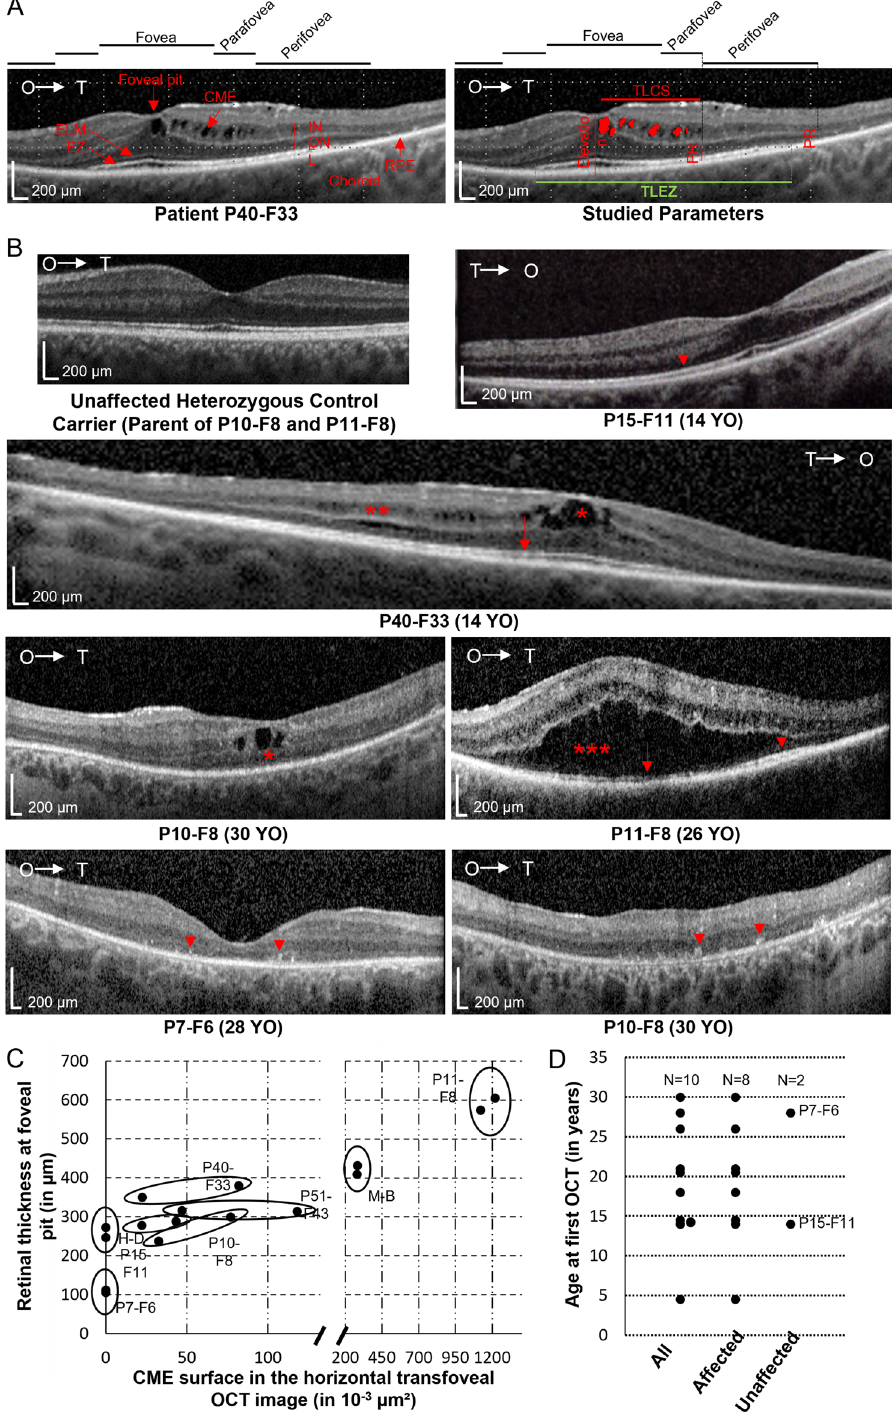
Figure 1. Macular lesions defined by OCT examinations in CS patients. ( A ) Parameters analyzed in this study are presented on an example of an OCT image from a CS patient (P40-F33). CM Cystoid Macular Edema, ELM External Limiting Membrane, EZ Ellipsoid Zone, INL Inner Nuclear Layer, ONL Outer Nuclear Layer, PR Photoreceptor-related layers, TLCS Transversal Length of Cystoid Space, TLEZ Transversal Length of Ellipsoid Zone. ( B ) Transfoveal OCT scans from CS patients P compared to an unaffected parent of P10-F8 and P11-F8 (upper left image) showing the variability of lesions affecting the macula. The lower right image is a parafoveal image showing hyperreflective foci in the outer retina. Arrows: Ellipsoid zone; Arrowheads: Hyperreflective foci; *CM in the INL; **CM in the ONL; ***severe discontinuation of the ONL due to CM. ( C ) Dot plot describing the variability and severity of cystoid spaces in CS patients. ( D ) Plot showing the age distribution of CS patients of this retrospective case series and the presence of CM in relation to the patients’